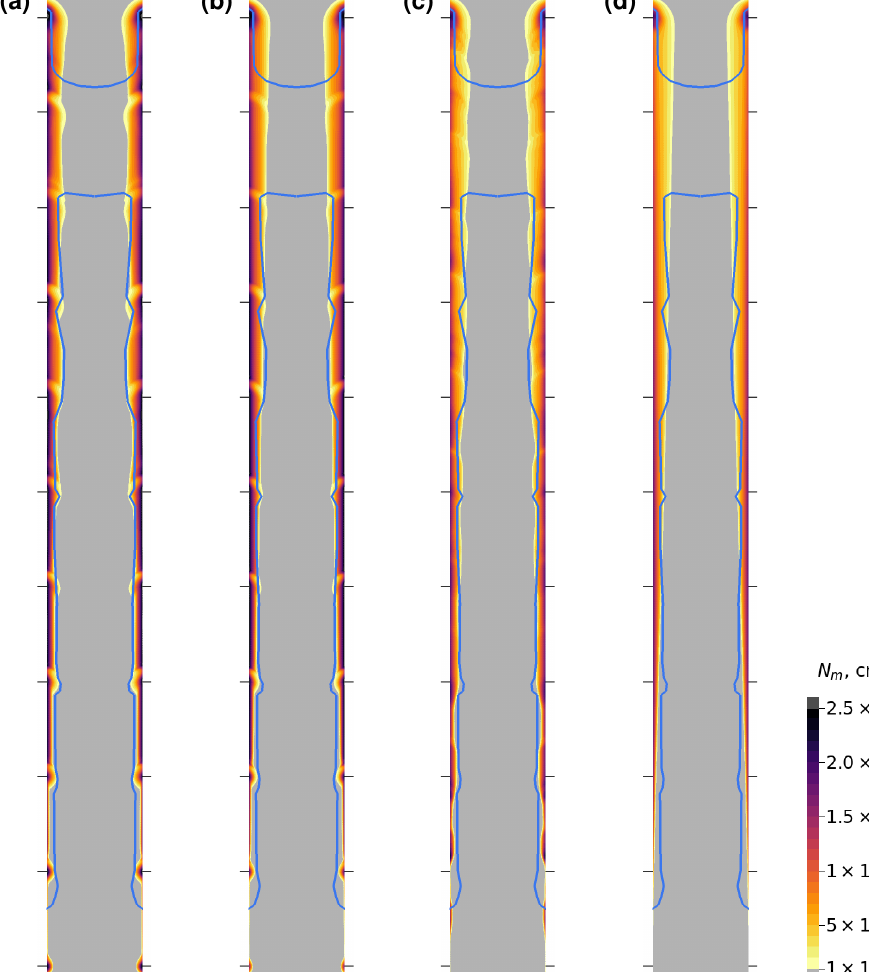
Figure 8. Dislocation density for simulation case F with varied I ( t ) and z ( t ) curves. ( a ) Default (step- wise) curves; ( b ) linear I ( t ) curve; ( c ) linear z ( t ) curve; ( d ) linear I ( t ) and z ( t ) curves. Experimentally observed boundary of the dislocated zone is depicted as blue curves. Black horizontal lines show heating positions at which the crystal was not